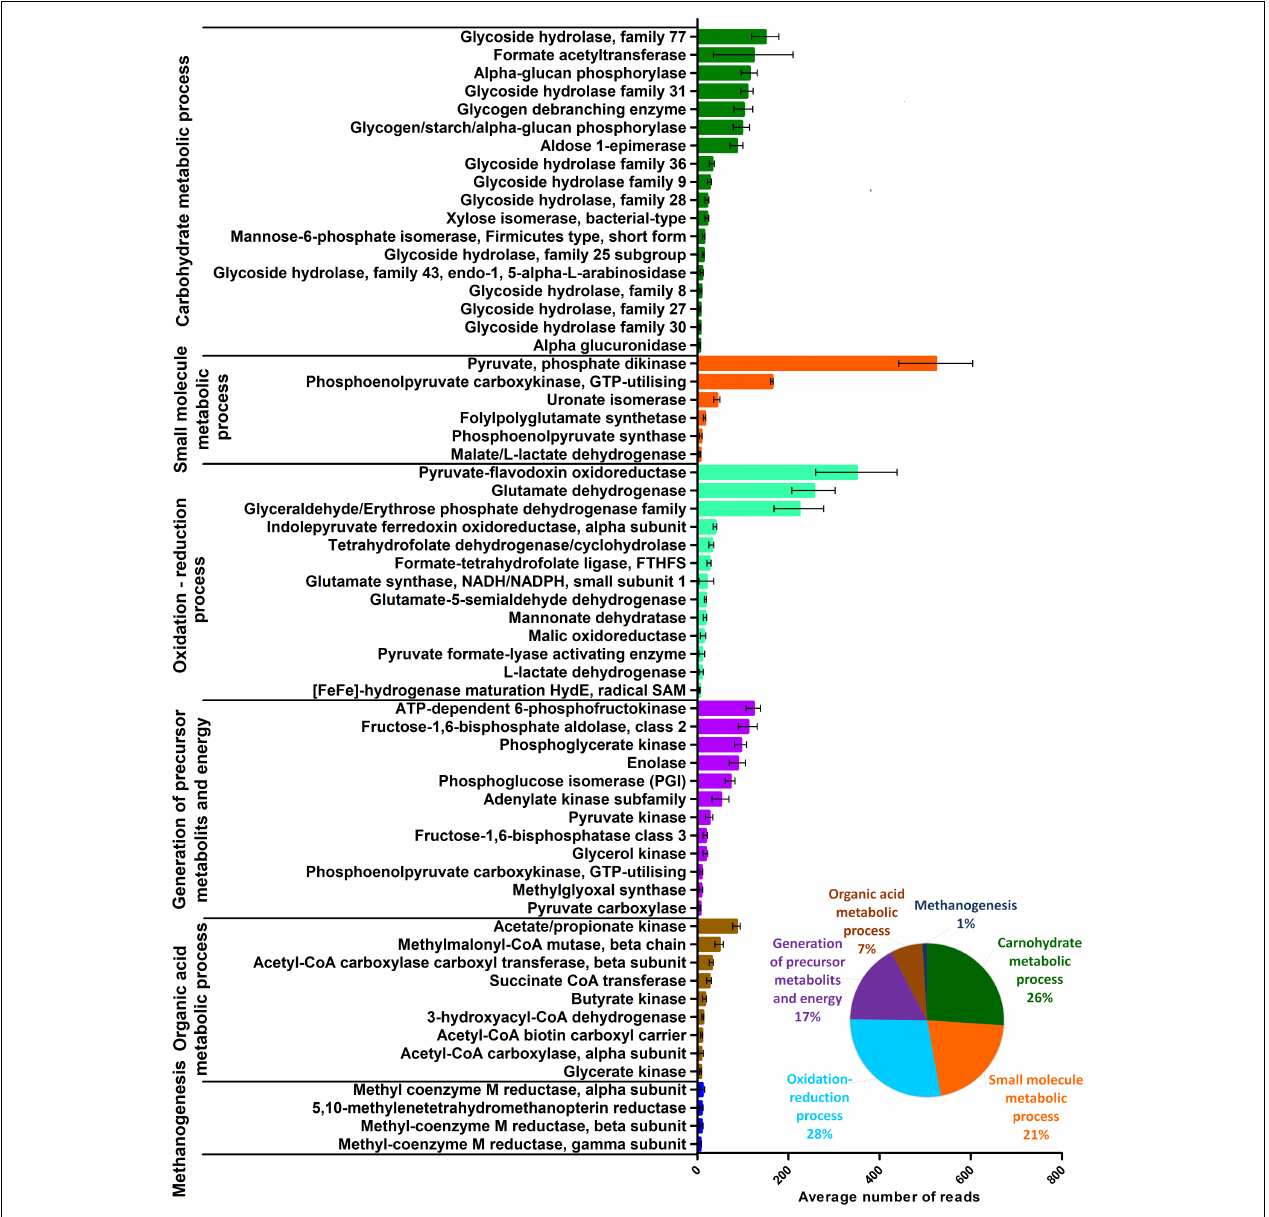
FIGURE 4 | The distribution of the core microbial functions calculated from the average RNA-based metatranscriptome dataset. Error bars indicate the variances among the individual 10 rumen samples. The inset indicates the relative partition of the functional groups within the